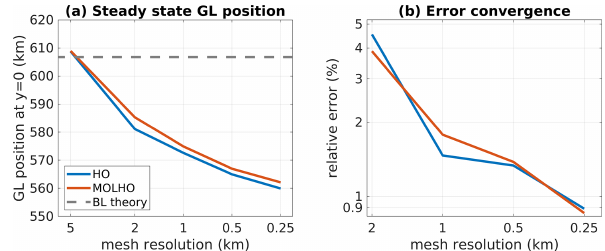
Figure 3. ISMIP-HOM experiment E: surface velocity in the ice flow direction obtained with the three-dimensional higher-order model (HO) and with the two-dimensional Mono-Layer Higher- Order (MOLHO) model. Two basal conditions are presented: frozen bed (a) and slip bed (b) . We employ eight vertical layers for the HO model.